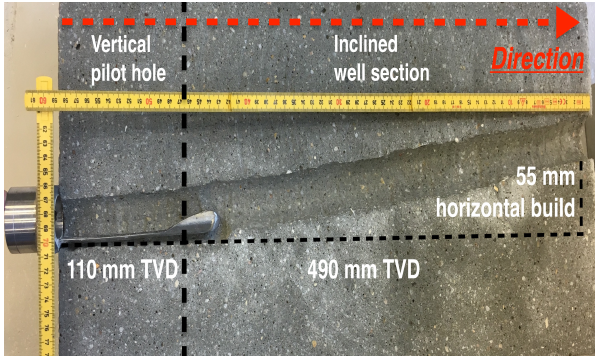
Figure 6: Well profile using 7 degrees whipstock in ho- mogeneous